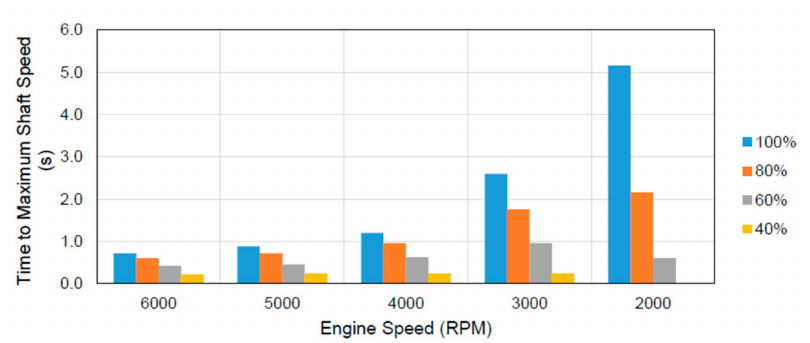
Figure 24. Baseline time to reach maximum shaft speed at various engine speeds and